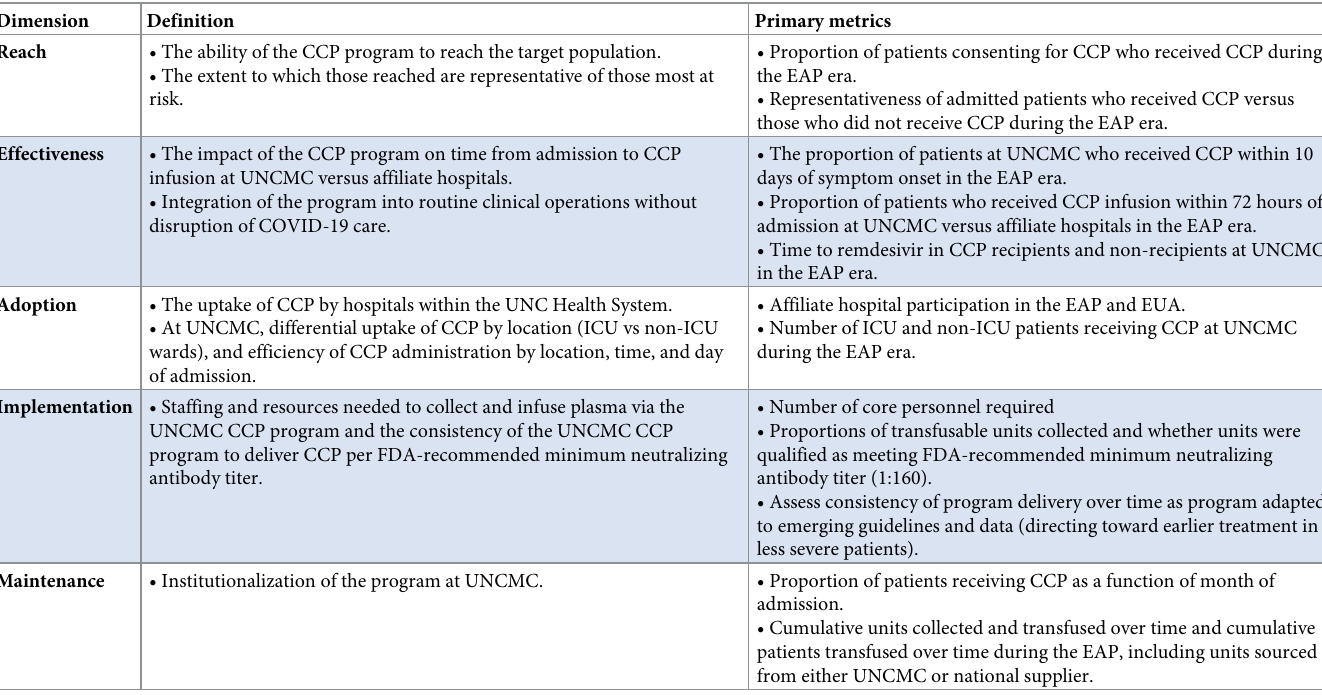
Table 1. Reach, Effectiveness, Adoption, Implementation and Maintenance (RE-AIM)